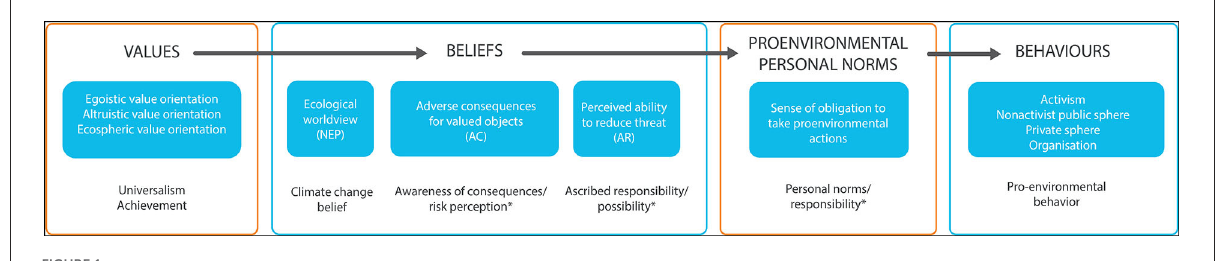
FIGURE1 Original VBN theory (Stern, 2000) is shown in blue boxes. Under the boxes, corresponding terms are used in literature. Terms marked in asterisk are used in this research.